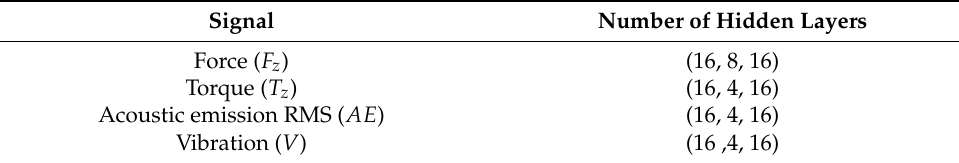
Table 2. Architecture used for each autoencoder.